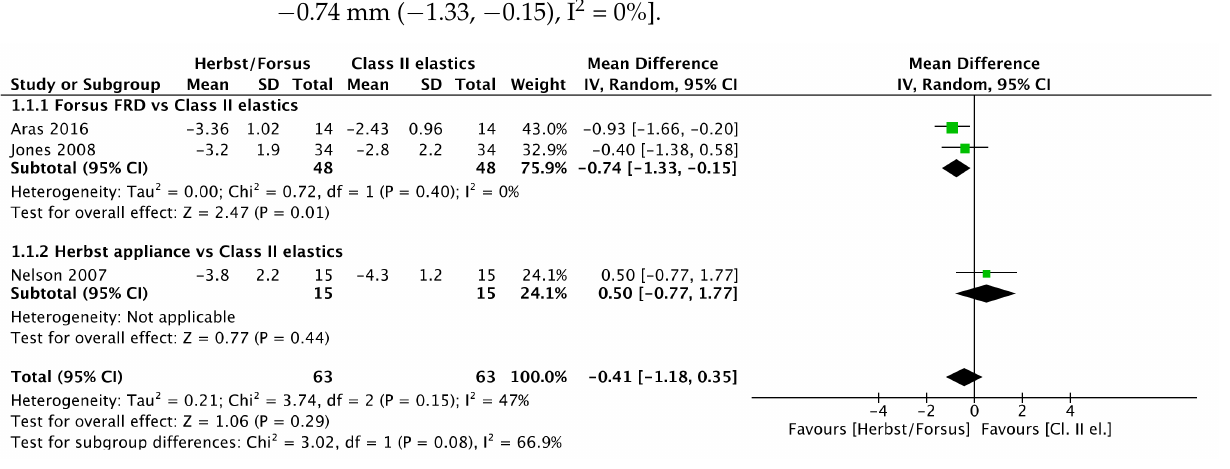
Figure 2. Forest plot of the overjet changes using the random effects model [39,41,46].